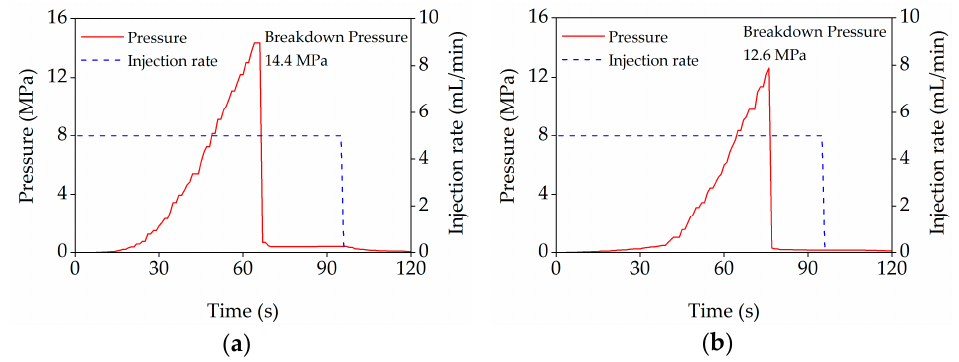
Figure 6. Pressure curves under different horizontal stress differences: ( a ) 10 MPa for specimen No. 3; ( b ) 5 MPa for specimen No. 6.